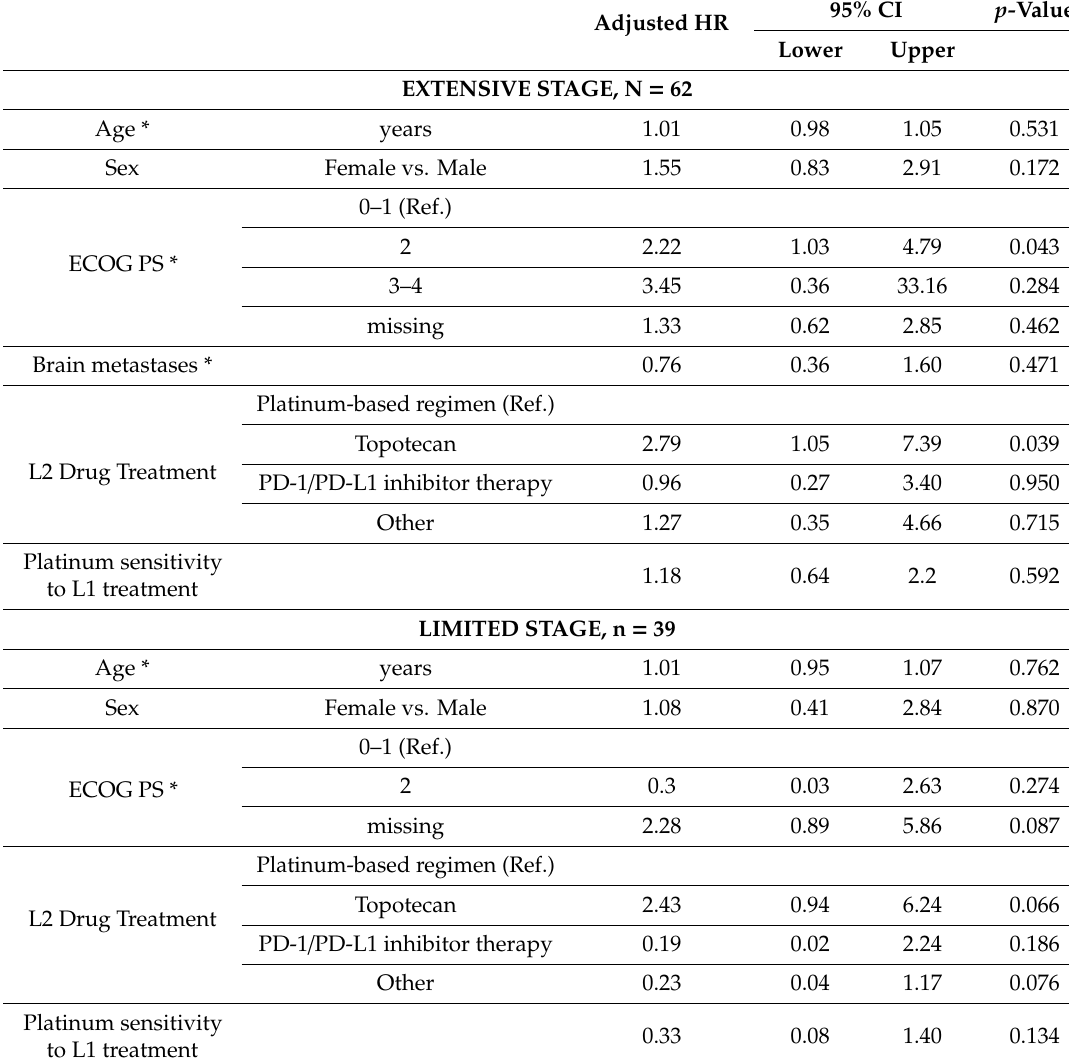
Table 4. Multivariable model for factors associated with survival from L2 treatment initiation (n =